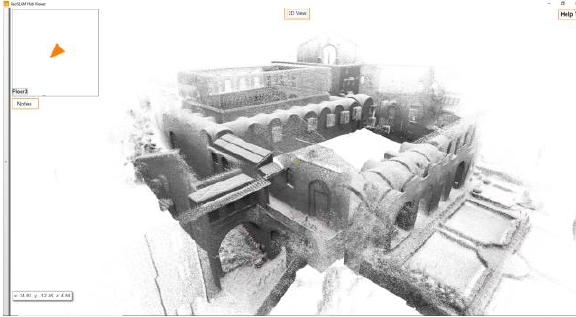
Figure 6. 3D visualisation and navigation through the point cloud within the Geoslam software.